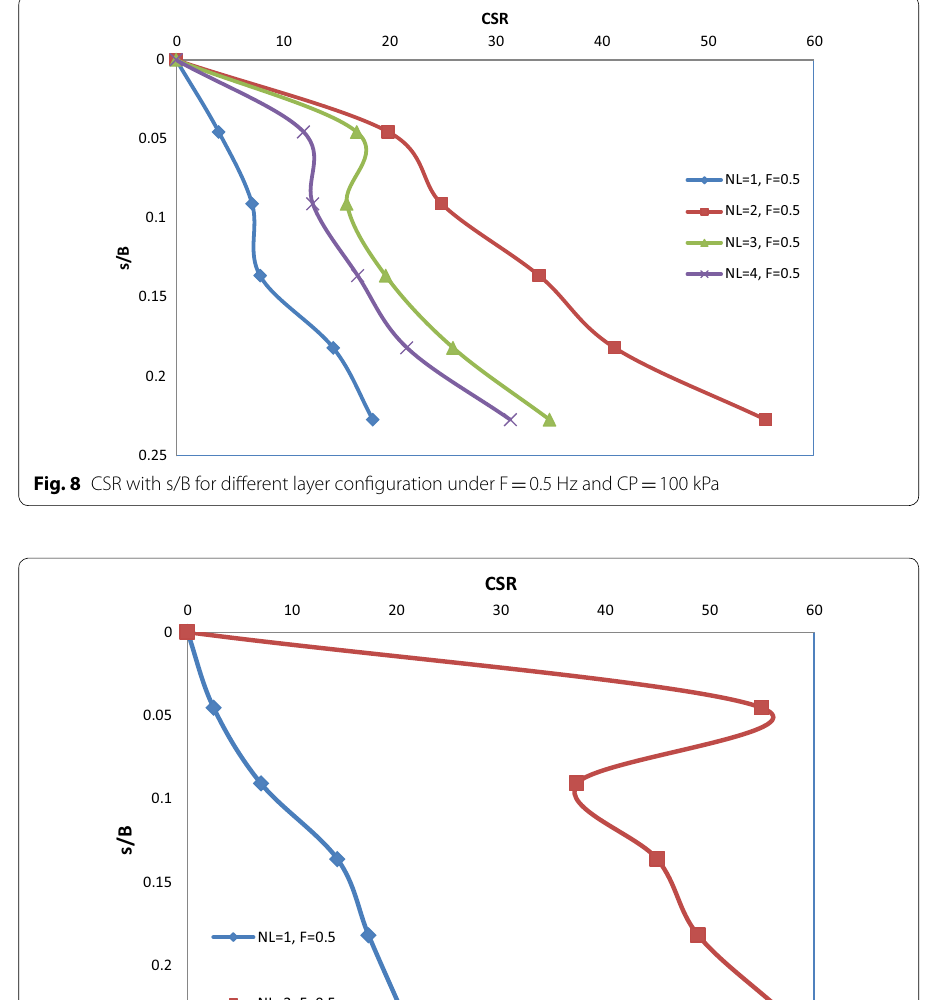
0.5 Hz and CP 300 = =